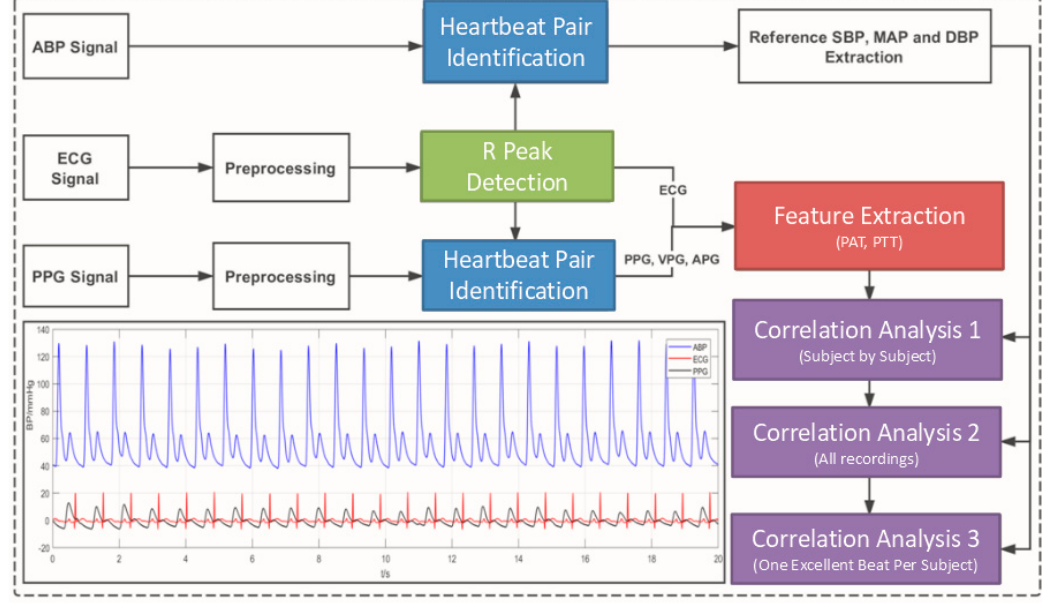
Figure 2. The workflow of this study. ABP is the arterial blood pressure, ECG is the electrocardiogram, PPG is the photoplethysmogram signal, VPG is the velocity of PPG, APG is the acceleration of PPG, PTT is the pulse transit time, and PAT is the pulse arrival